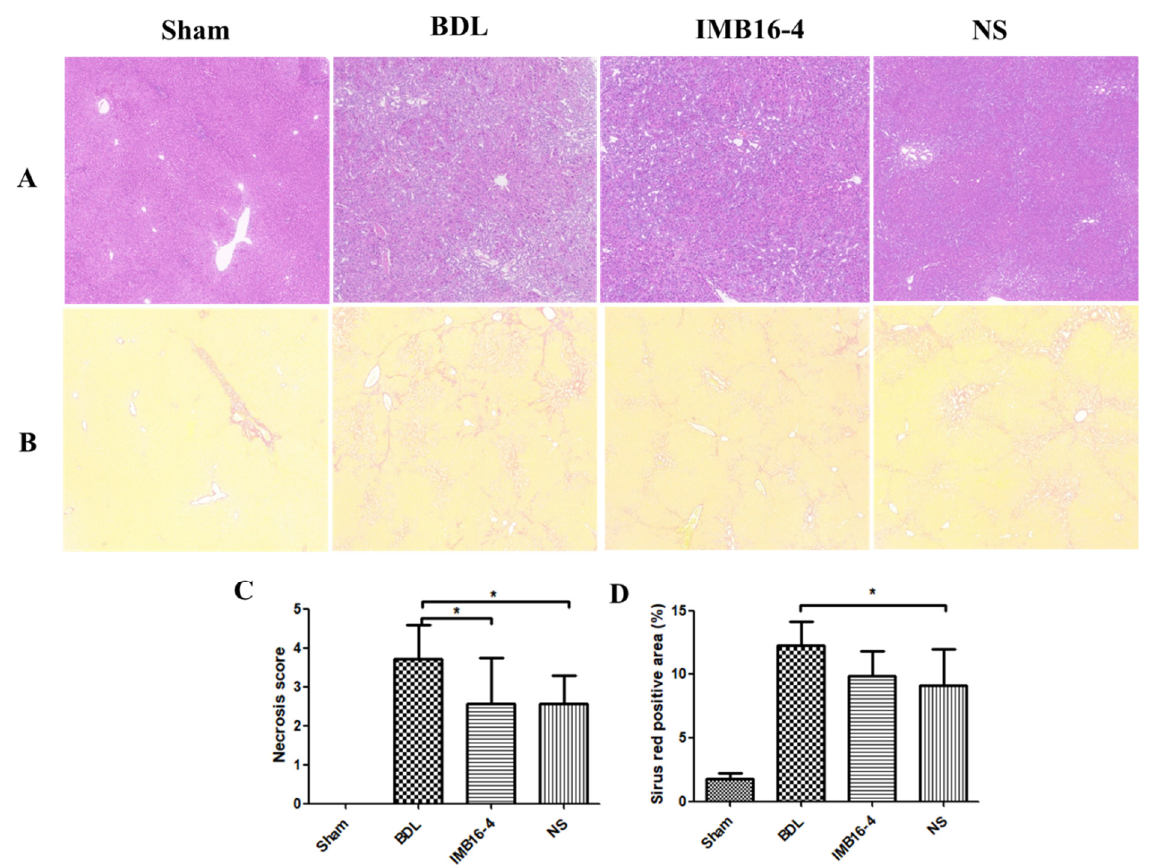
Figure 6. IMB16-4 and NS markedly improved liver fibrosis in BDL rats: ( A ) Liver pathological changes were detected by H&E staining. ( B ) The degree of liver collagen accumulation was determined by Sirius red straining. ( C ) Blinded quantitative assessment hepatic necrosis score. ( D ) The percentage of Sirius red positive areas. * p < 0.05 significantly different from BDL group. Table 4. Serum biochemical markers of bile duct ligated (BDL)-treated rats, Mean ± SD, n =